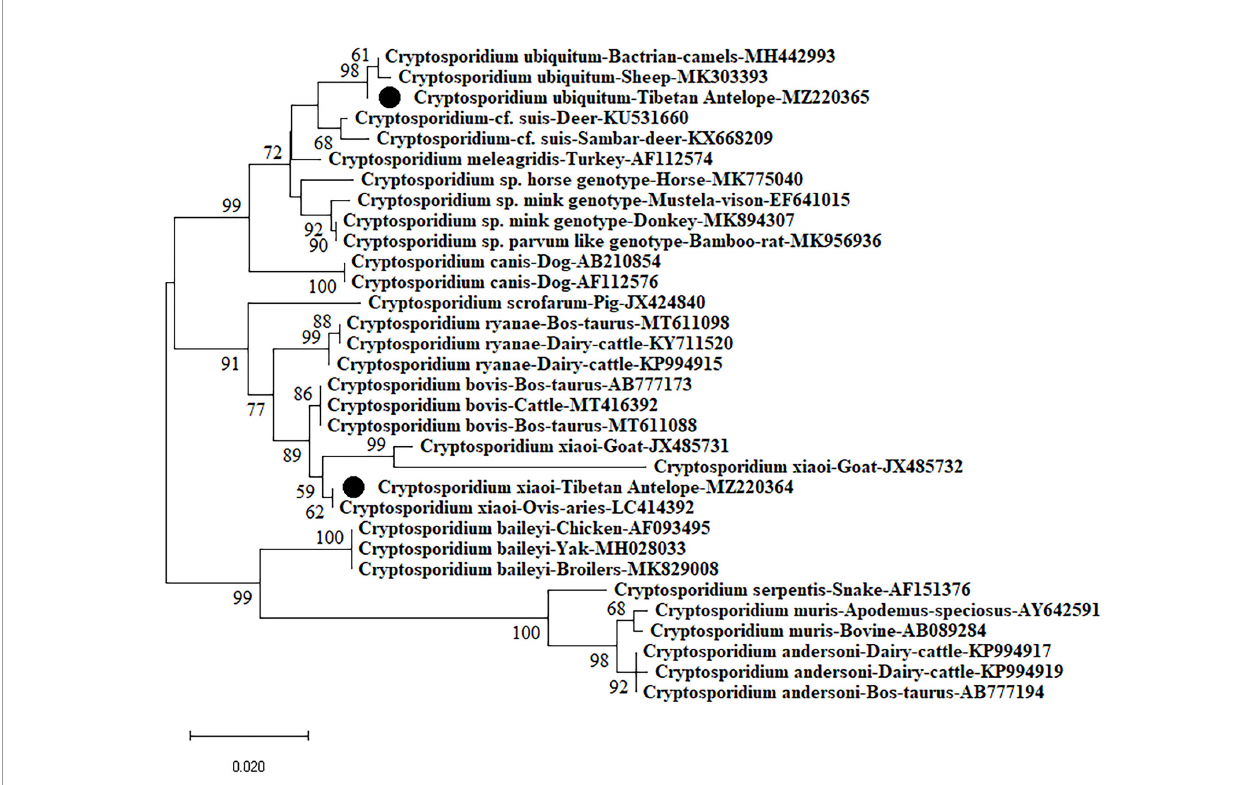
FIGURE 3 | Phylogenetic analyses of Cryptosporidium using neighbor-joining (NJ) method (Kimura 2-parameter model). Bootstrap values below 50% are not shown (1,000 replicates). Cryptosporidium isolates identi fi ed in the present study are indicated by solid